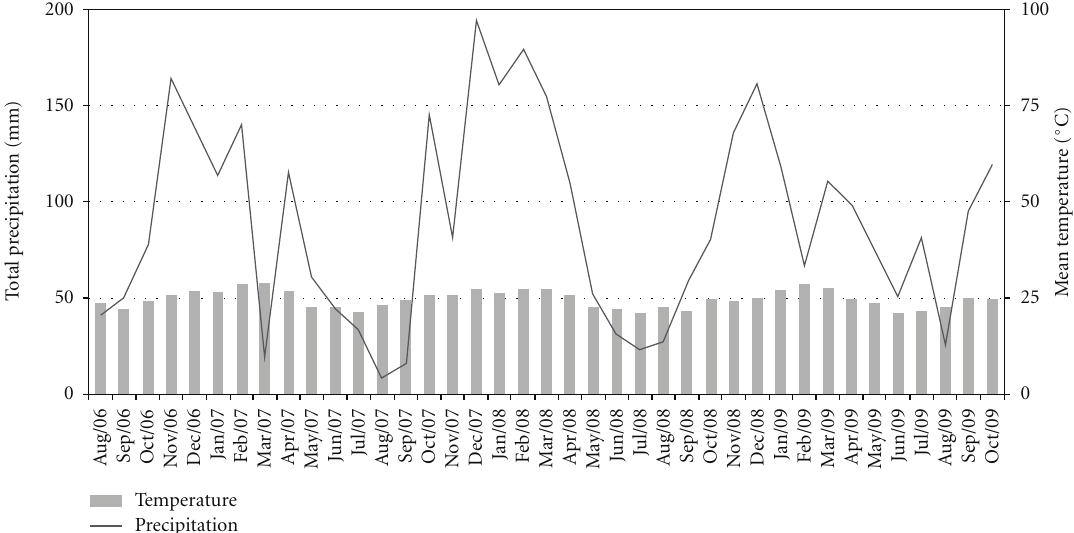
Figure 1: Monthly means of temperature ( ◦ C) and precipitation (mm) registered by INMET, in the west zone of Rio de Janeiro city, Southeast Brazil, August 2006 to October 2009.